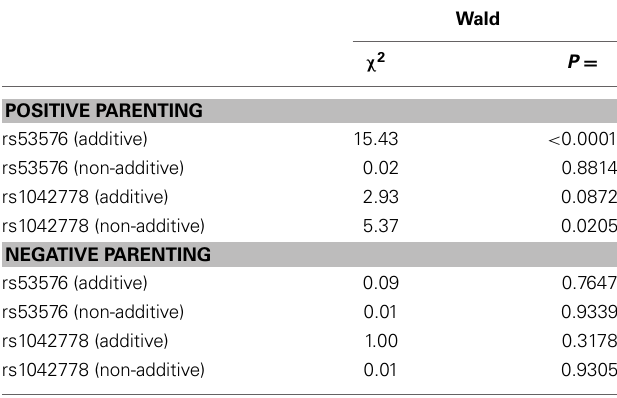
Table 1 | Simultaneous associations of each term for additive and non-additive associations (each 1 DF) between OXTR SNPs with positive and negative maternal parenting (in separate analyses), adjusting for all covariates; N = 35.